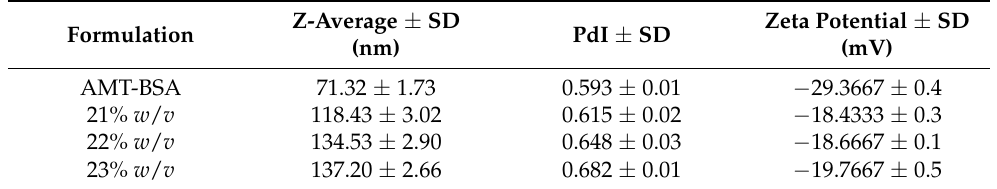
Table 2. Nanoparticulate characteristics (Z-average, PdI, and ZP) of AMT-BSA-loaded nasal formula- tions containing different amounts of P407. Data are presented as means ± SD ( n = 3).